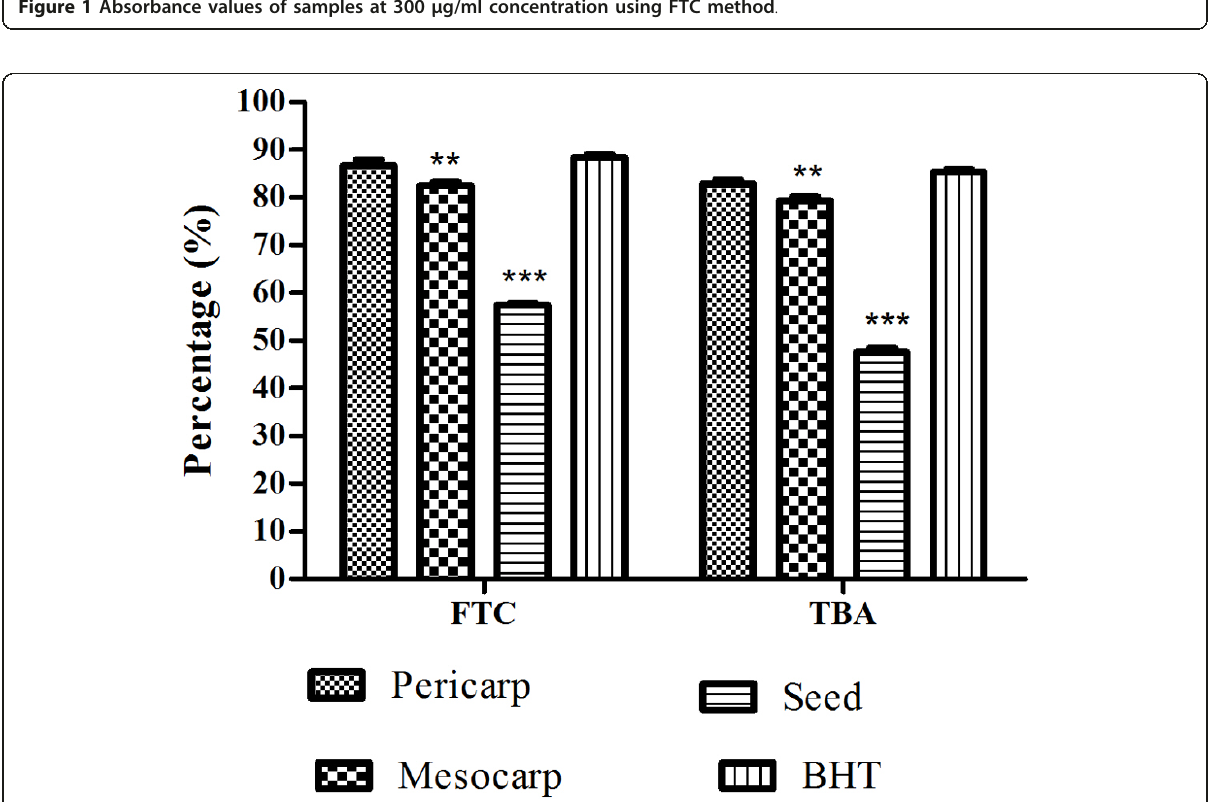
Figure 2 Total antioxidant activity assayed by the FTC and TBA methods on day 9 . Each bar represents the mean ± standard error in three independent experiments. **P < 0.01, ***P < 0.001 indicates significant difference as compared to